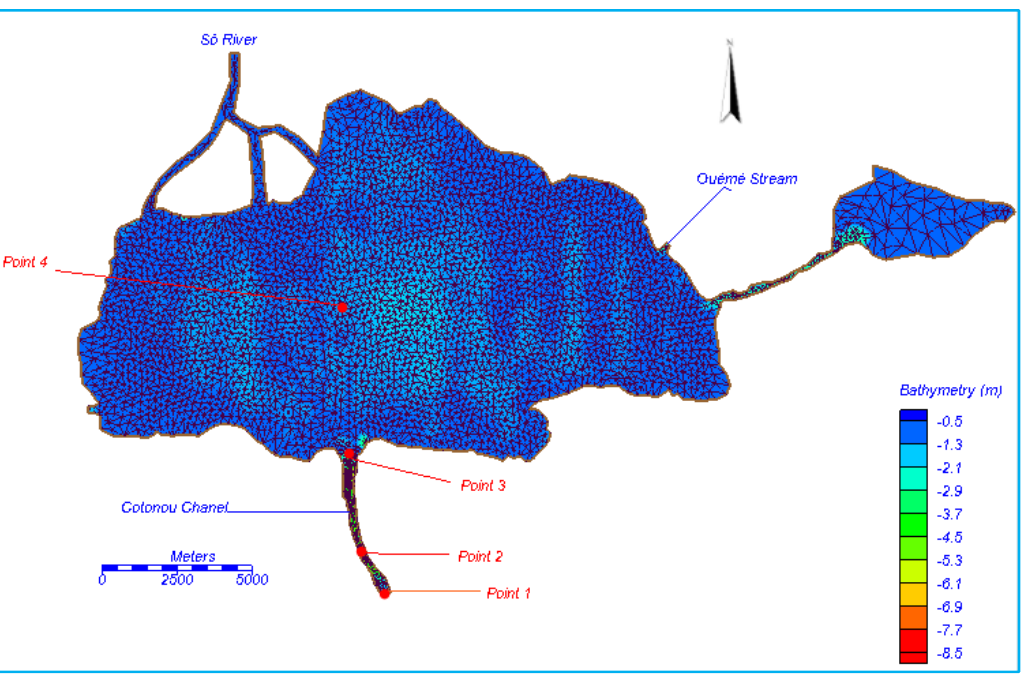
Figure 2. Bathymetric map and meshing of Nokoué Lake.